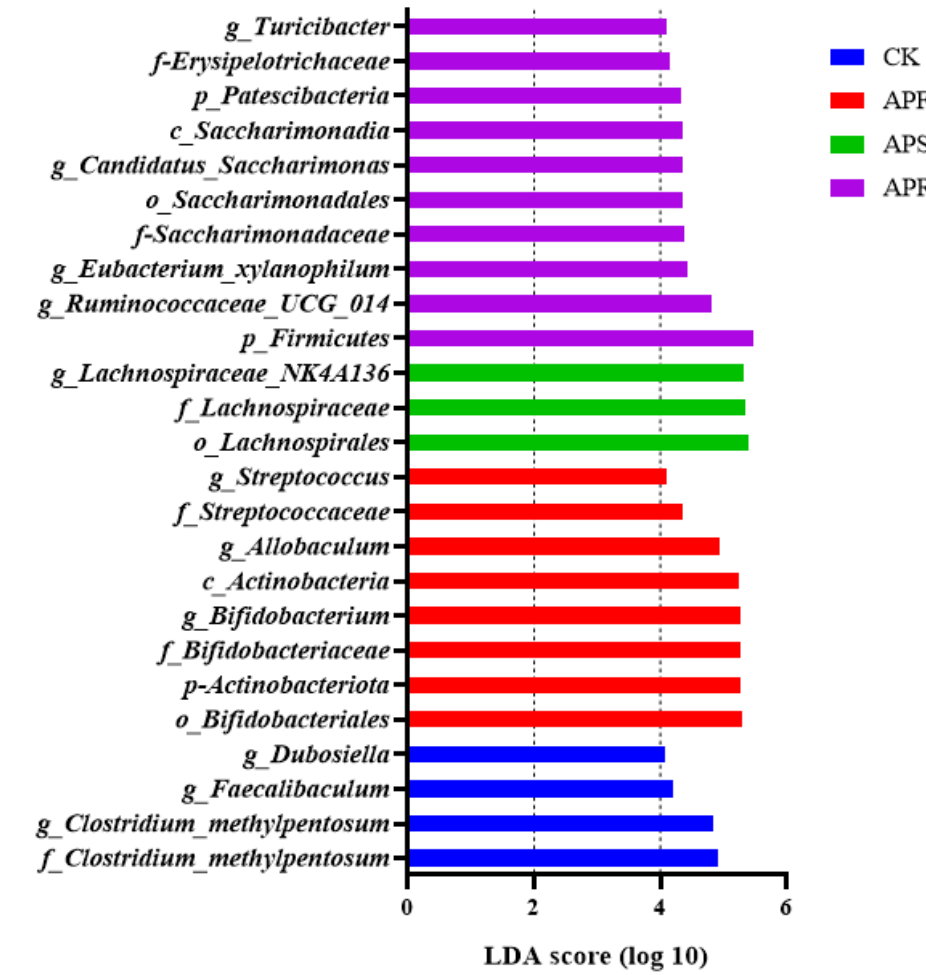
Figure 3. Linear discriminant analysis effect size (LEfSe) showing the contribution of different bacteria to the differences among the groups.